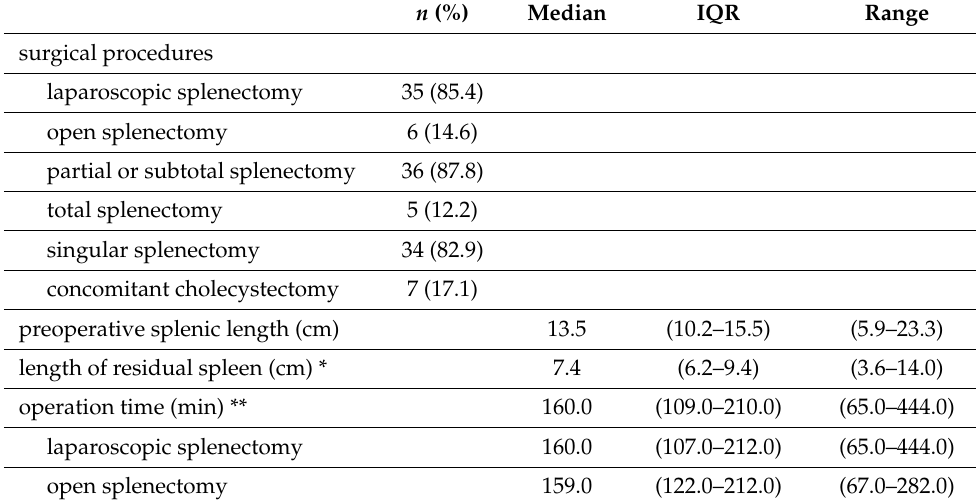
Figure 2. ( a ) Comparison of partial and total splenectomy operation times in minutes. ( b ) The correlation between the length of stay (days) and the operation time (minutes) is strong, with r = 0.744. ( c ) The operation time for splenic cysts in relation to the length of stay (days) demonstrates only a weak correlation with an r of 0.525. Table 2. Surgical data (total n = 41).